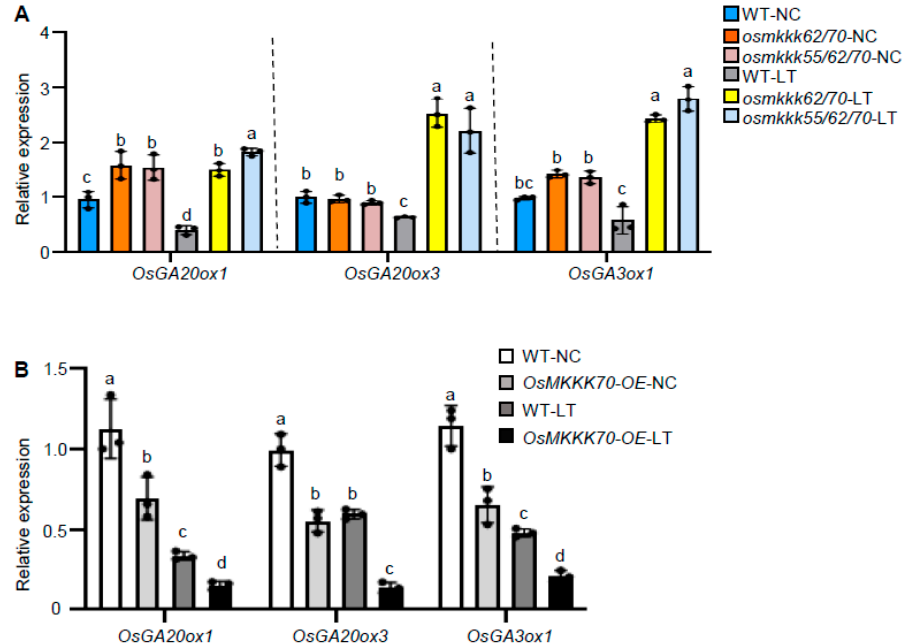
Figure 6. OsMKKK70 negatively regulates GA biosynthesis gene expression in anthers. ( A ) The expression of GA biosynthesis genes in anthers of WT, osmkkk62/70, and osmkkk55/62/70 plants grown under NC and after LT treatment for 4 days. Data are shown as means ± SE (n = 3). ( B ) The expression of GA biosynthesis genes in anthers of WT and OsMKKK70-OE plants grown under NC and after LT treatment for 4 days. Data are shown as means ± SE (n = 3). Each dot represents the result from one biological replicate; error bars indicate means ± SE. Statistically significant differences are indicated by different lowercase letters ( p < 0.05; one-way ANOVA with Tukey’s signifi- cant difference test).